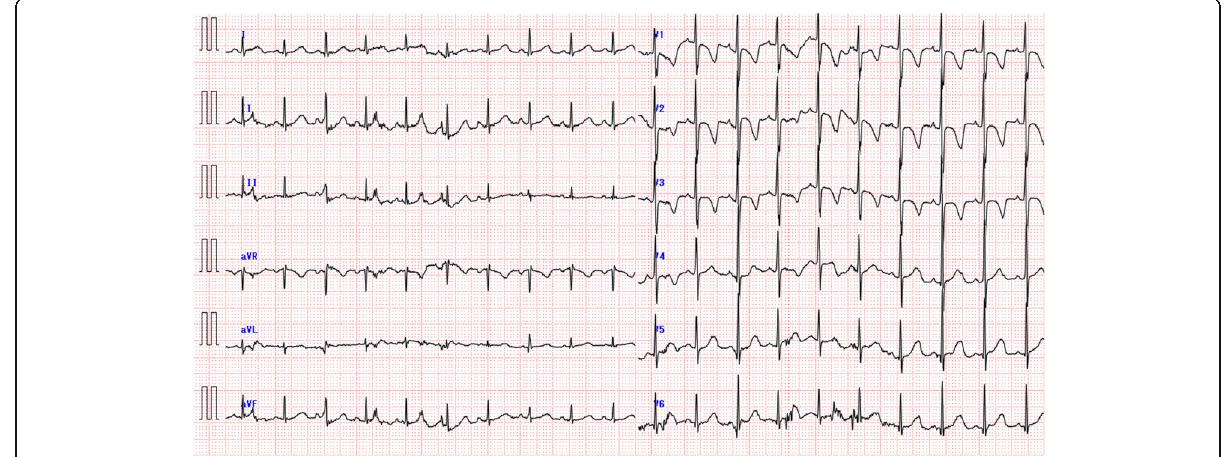
Fig. 1 Pre-operative 12-lead electrocardiogram revealing normal sinus rhythm with normal QRS complexes and ST